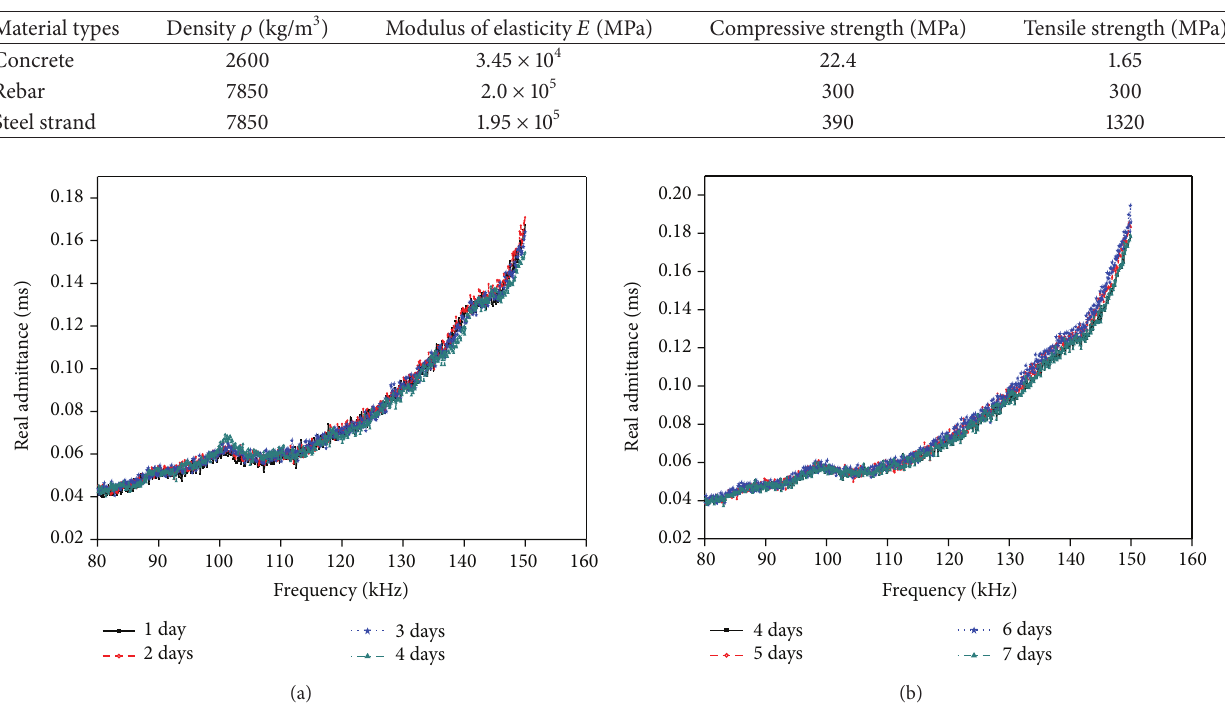
Figure 3: Real admittances of the PZT impedance sensors waterproofed by asphalt lacquer: (a) 1–4 days and (b) 4–7 days.